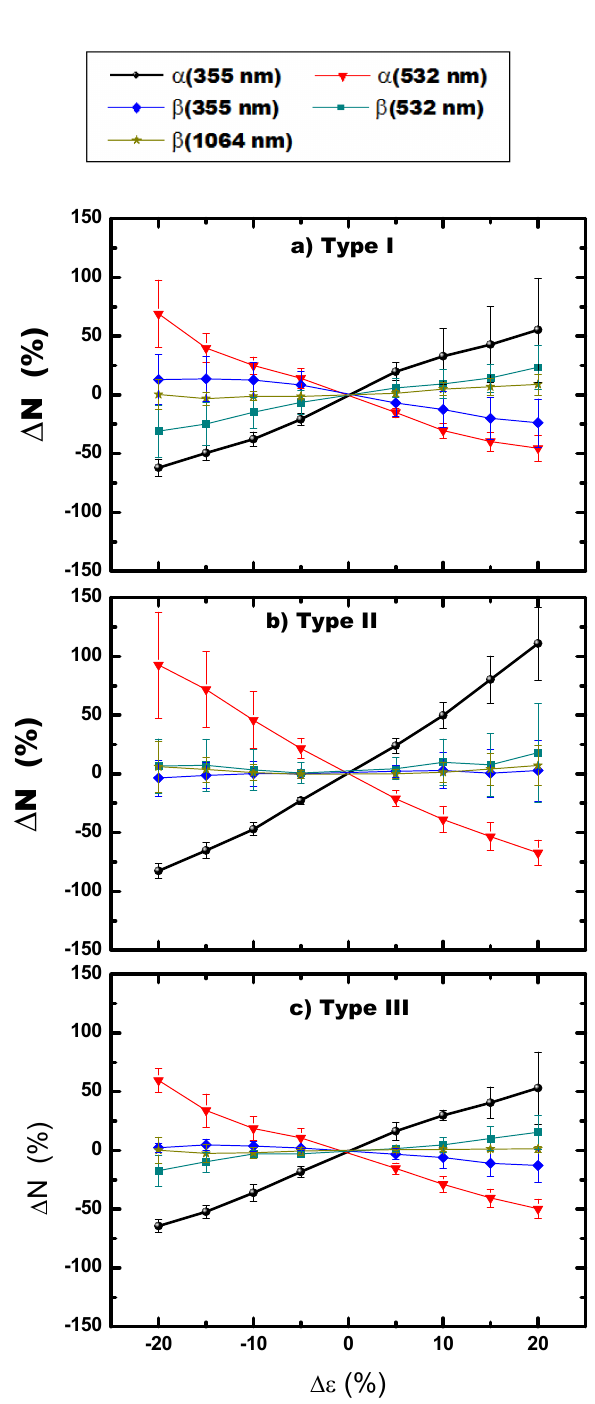
Figure 3: Percentage deviation of the number concentration as a function of systematic bias in the Fig. 3. Percentage deviation of the number concentration as a func- tion of systematic bias in the optical data ( ε) . (a) Type I, (b) type II optical data ( ε ). a) Type I. b) Type II. c) Type III. and (c) type